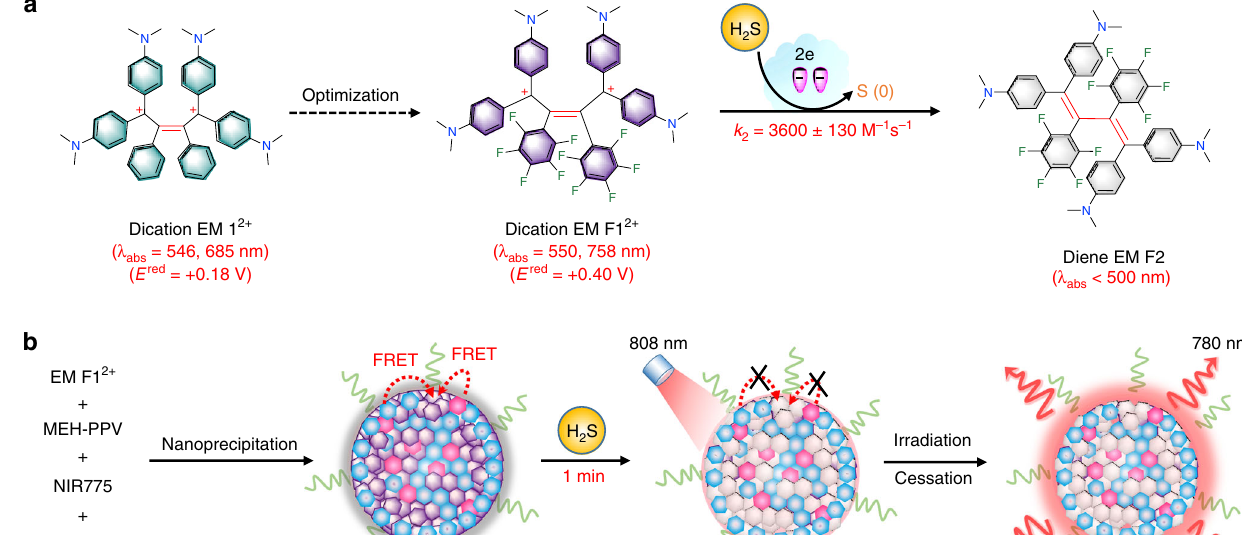
from three measurements)